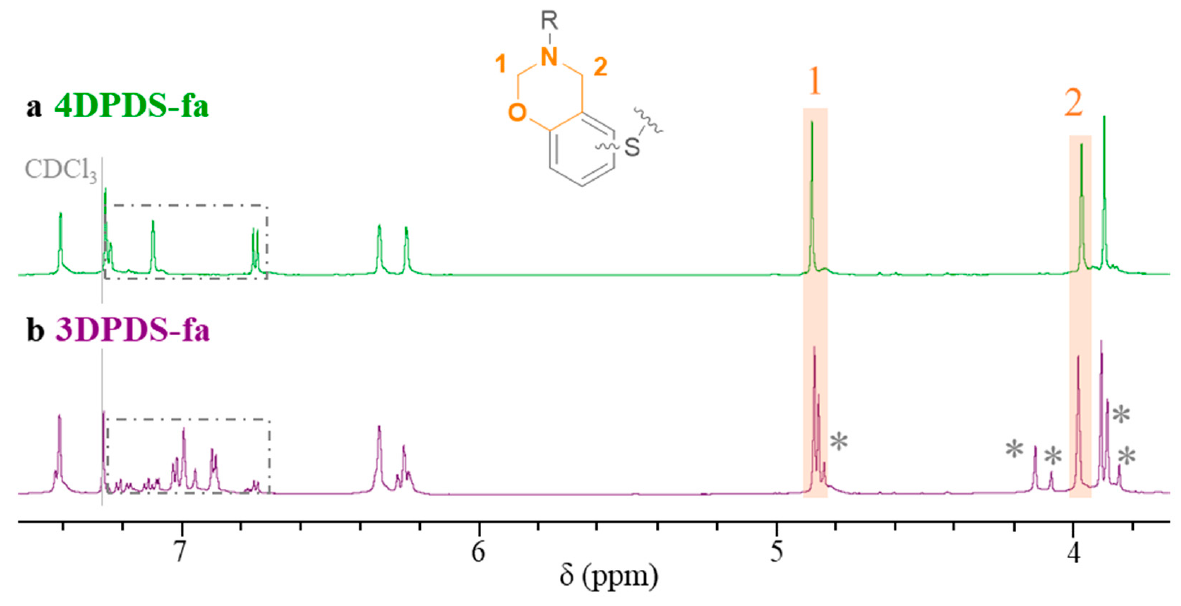
Figure 1. 1 H nuclear magnetic resonance (NMR) spectra in CDCl 3 of ( a ) 4DPDS-fa, and ( b ) 3DPDS-fa.